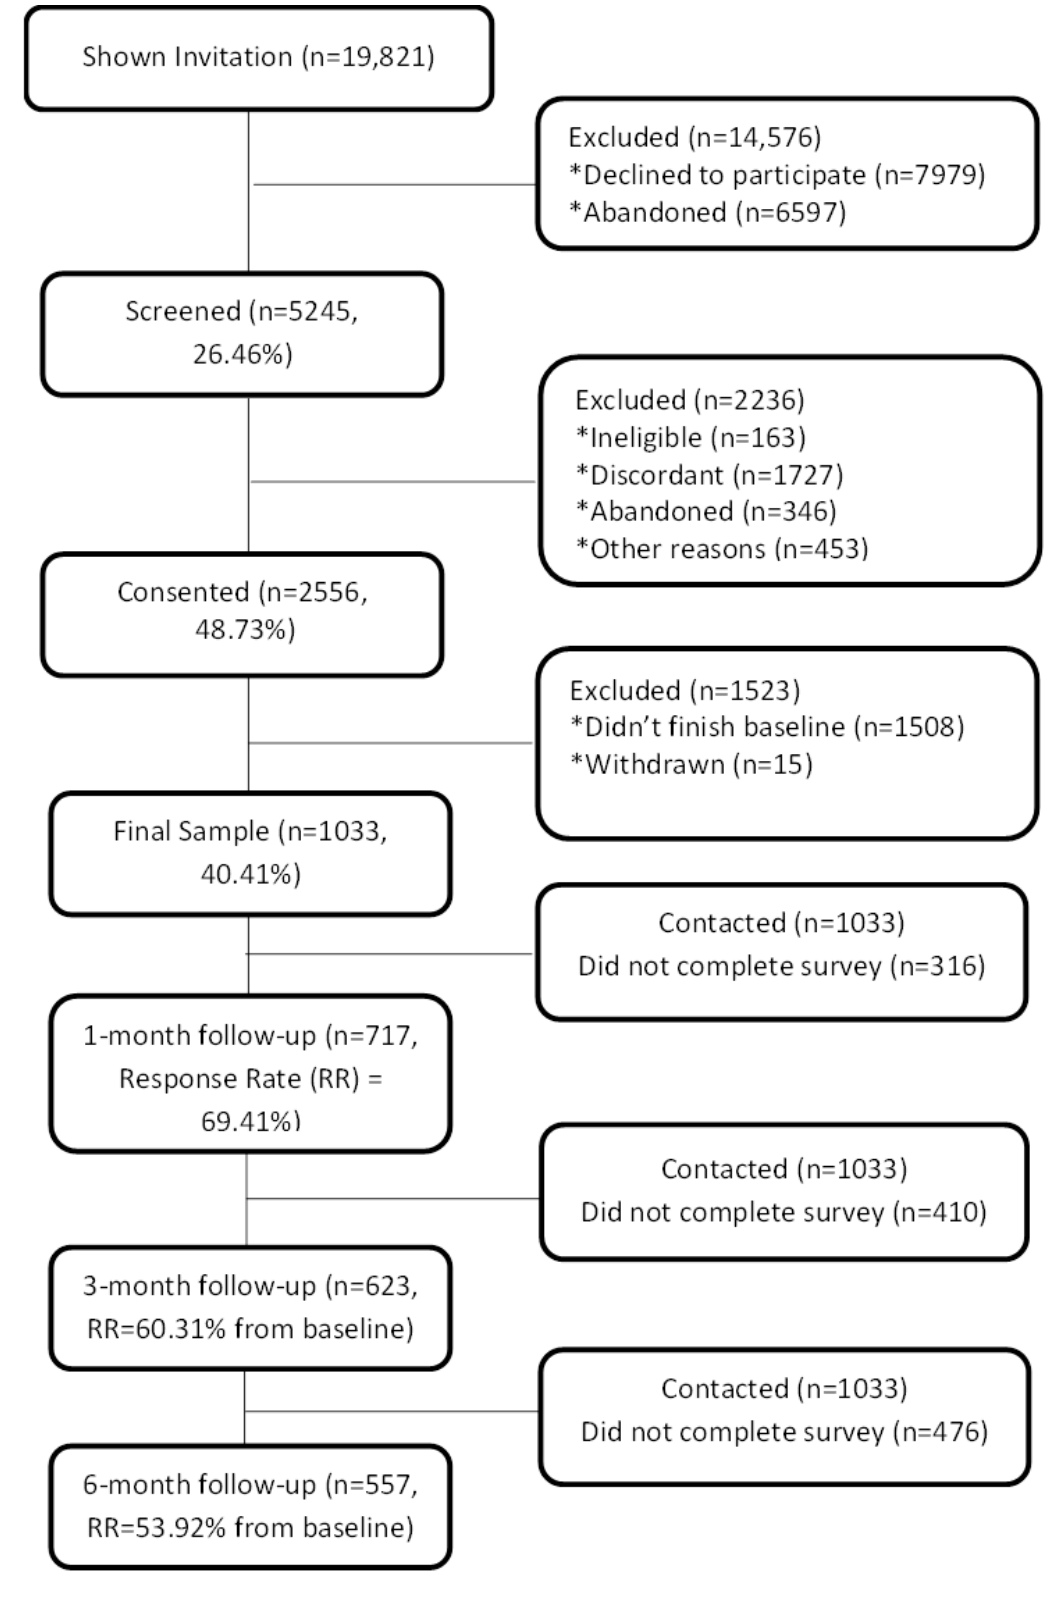
Figure 3. CONSORT diagram of study